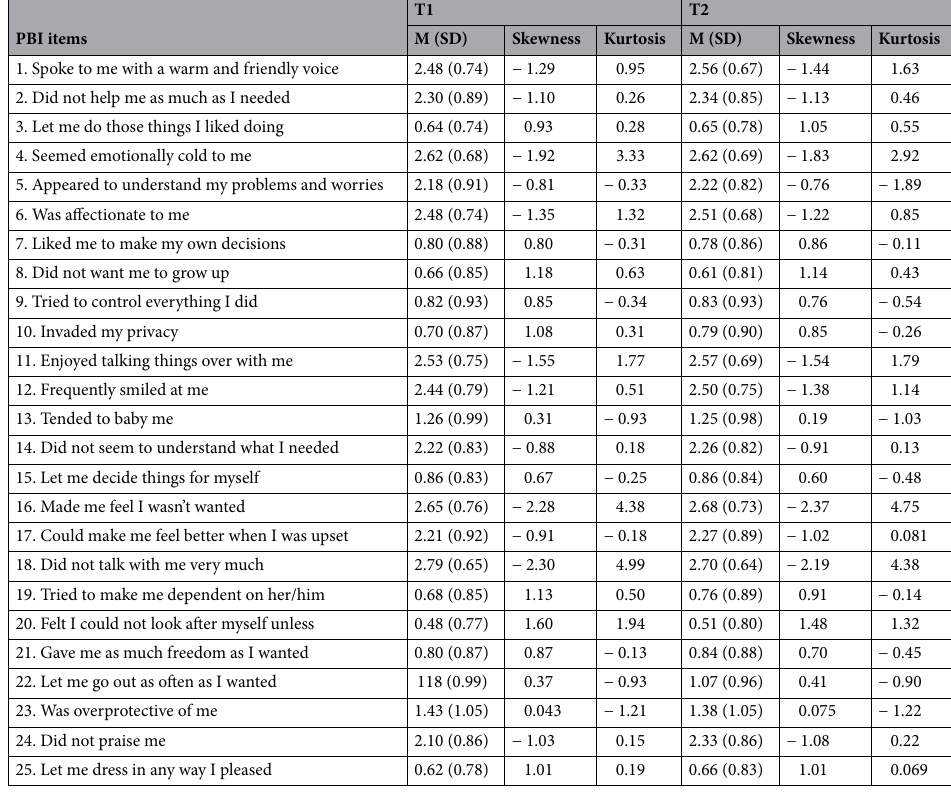
Table 2. Means, SD, skewness, and kurtosis in this study (Mothers). PBI: Parental Bonding